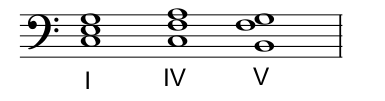
FIGURE 6 | C major chords in the accompaniment position.